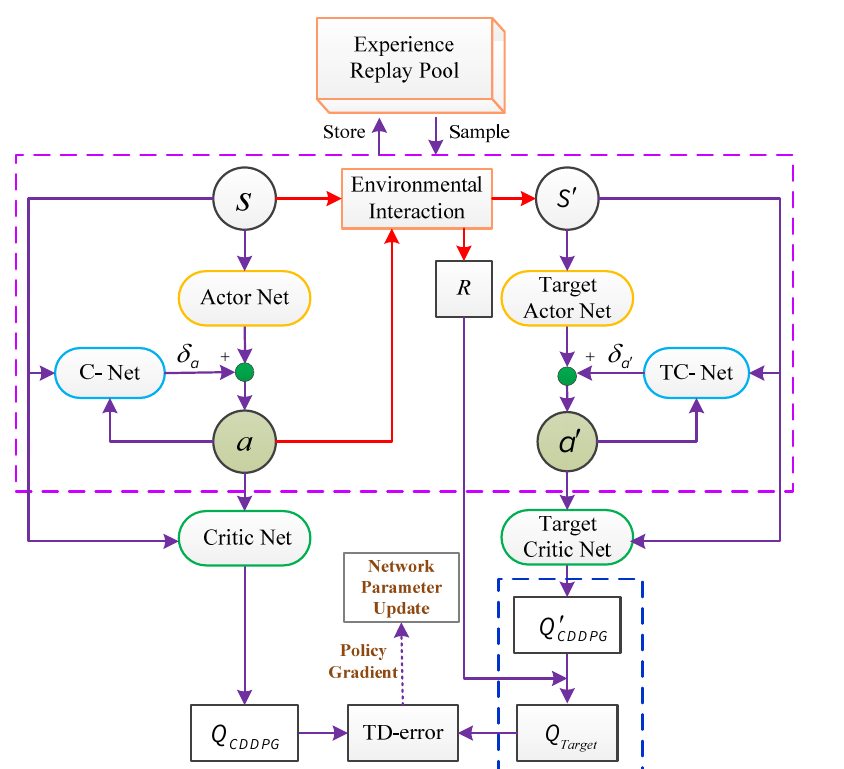
Figure 3. CDDPG algorithm schematic diagram. Algorithm 1: CDDPG Algorithm